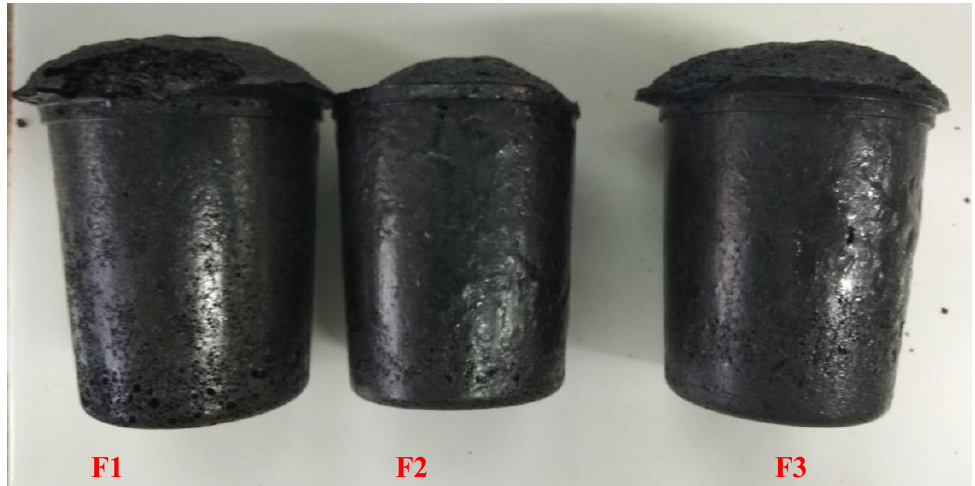
Figure 1. Picture of furanic-glyoxal foams prepared according to the formulations in Table 1.